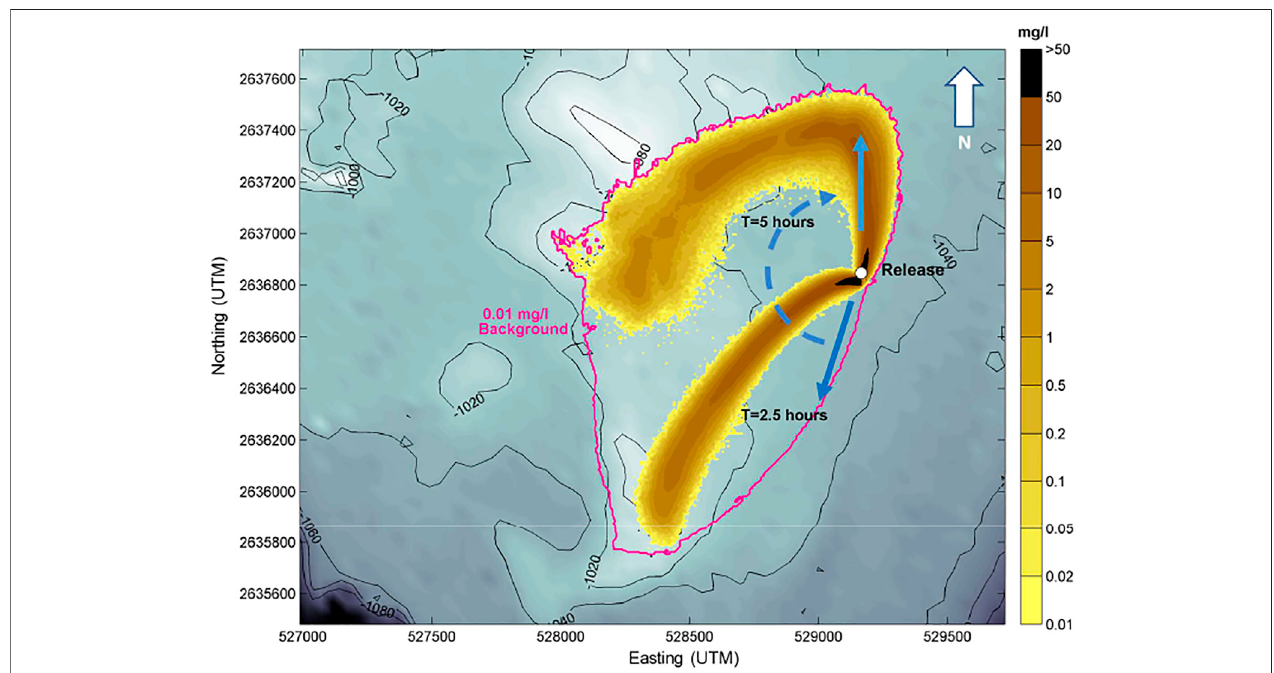
FIGURE4| Snapshotsofpredictedincreasesinsuspendedsedimentconcentration(averaged overbottom10 mofwatercolumn)resultingfrom5-hsimulationof mining on the Tropic Seamount with representative rates of release. Snapshots shown at +2.5 h and +5 h. Envelope of increases greater than 0.01 mg/L (equivalent to background) over whole of simulation are indicated by magenta line (Spearman et al.,